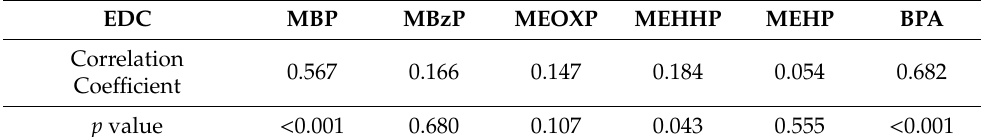
Table 4. Correlation coefficients (Spearman’s ρ ) between serum and follicular EDCs.